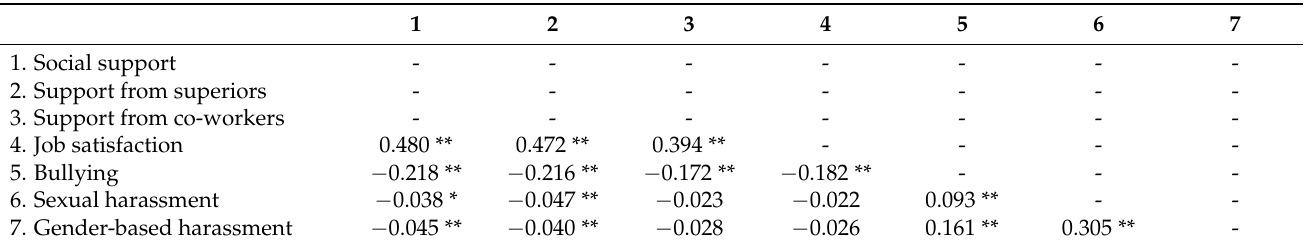
Table 4. Correlation between social support, job satisfaction, bullying, sexual harassment and gender- based